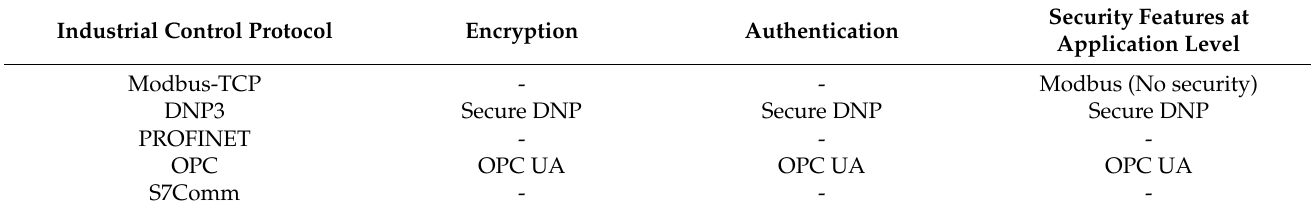
Table 3. Analysis of the security elements of key control